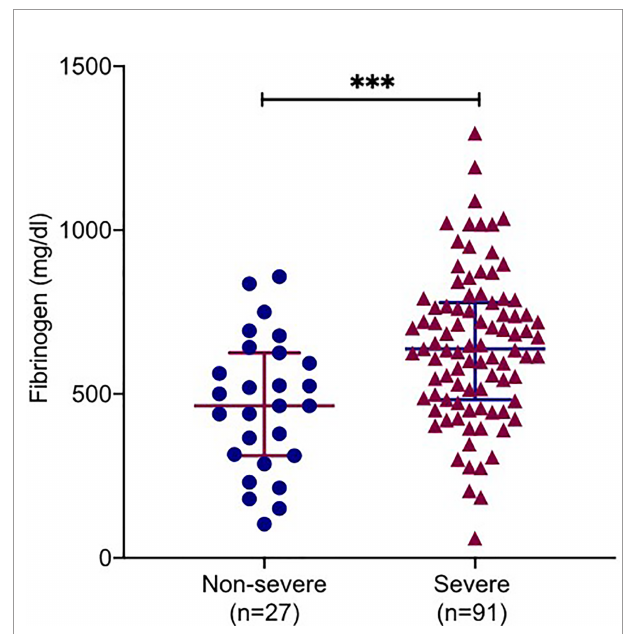
FIGURE 1 | Correlations of fi brinogen levels with clinical severity. Plasma fi brinogen levels in COVID-19 patients with severe and non-severe. All data points are shown and mean ± 95% con fi dential intervals (CI) are shown by horizontal bars. student t -test was performed to determine the statistical signi fi cance. Here, *** indicate a P value <